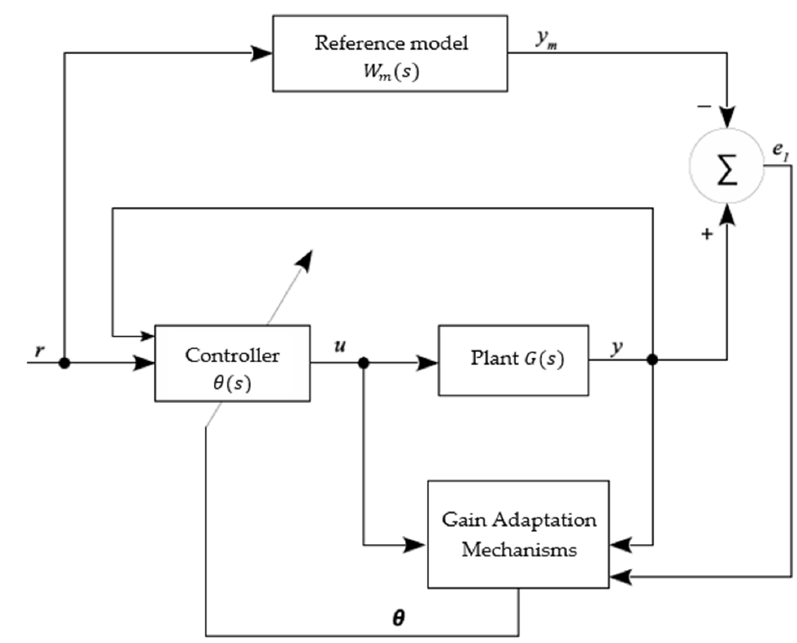
Figure 3. Adaptive controller by reference model.